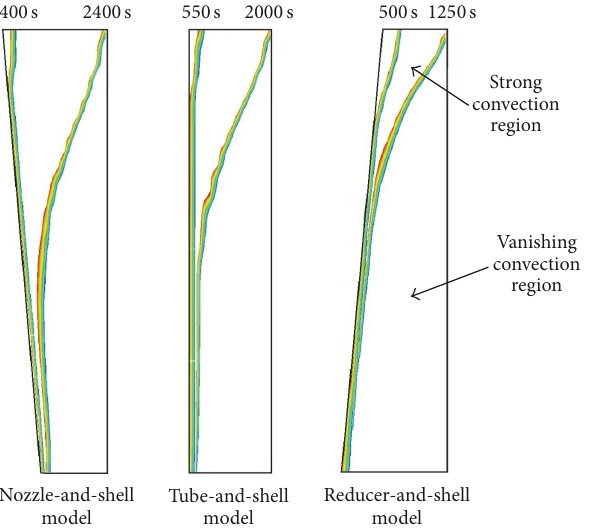
Figure 11: Liquid-solid interface at the time there was a change of Nusselt